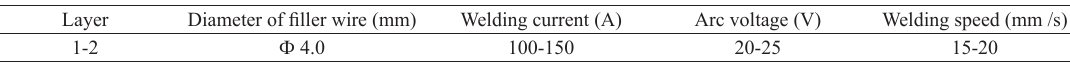
Table2. The welding parameters of SMAW welding for P91 heat-resistant steel tube Layer Diameter of filler wire (mm)